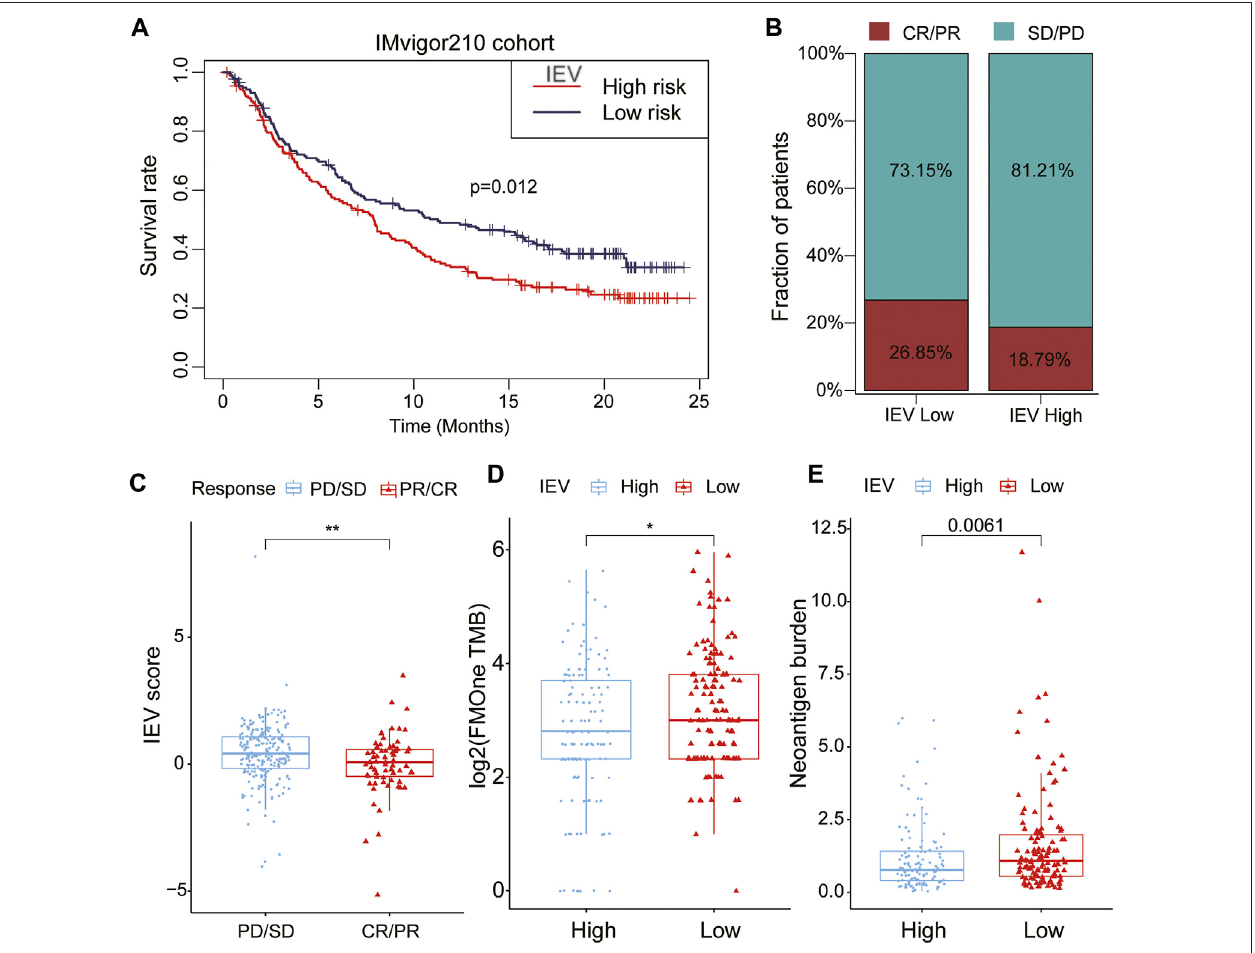
FIGURE 8 | Potential of Immune evasion-related genes signature (IEVSig) in guiding cancer immune therapy. (A) Kaplan – Meier curves of the low- versus high-risk subgroupintheIMvigor210 cohort(anti-PD-L1cohort). (B) theproportionofimmune therapyresponse toanti-PD-L1treatment inlow-versushigh-risksubgroups.CR, complete response; PR, partial response; SD, stable disease; PD, progressive disease. (C) distribution of IEVSig score between distinct immune therapy response statuses (PD/SD vs. CR/PR). (D,E) tumor mutation load (D) and neoantigen burden (E) in the anti-PD-L1 cohort were compared between distinct IEVSig